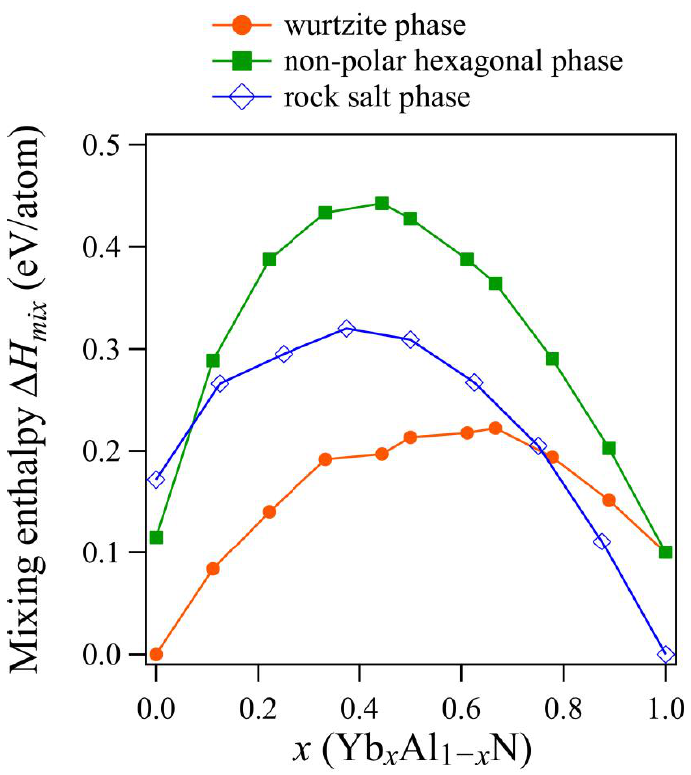
Figure 2. Calculated mixing enthalpies of each phase in Yb x Al 1−x N. Blue, orange, and green traces correspond to the mixing enthalpies of rock salt, wurtzite, and non-polar hexagonal phases, respectively.